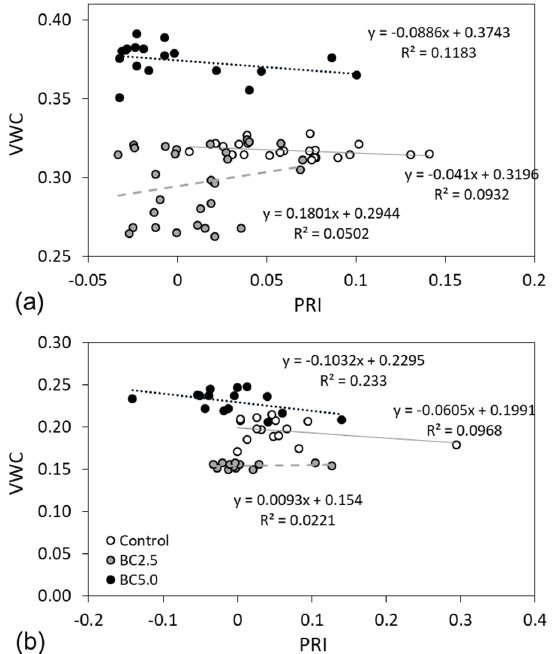
Figure 7. Relationships between midday average photochemical reflectance index (PRI) and volumetric water content (VWC, v / v ) values for control, BC2.5, and BC5.0 treatments at ( a ) maximum and ( b ) minimum daily water contents.